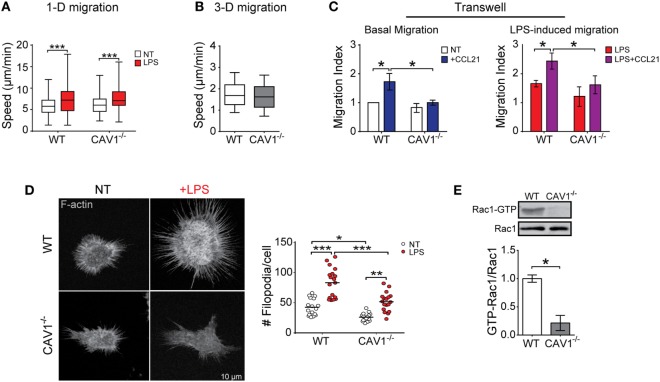
Caveolin-1 (CAV1) promotes dendritic cell (DC) transmigration, actin membrane protrusions, and Rac1 activation. Migration of wild-type (WT) or CAV1−/− bone marrow-derived DCs (BM-DCs) in different in vitro assays. (A) BM-DCs treated or not with LPS (1 µg/ml, for 30 min) were individually tracked in confined microchannels (4 µm). After 5–6 h, cell images at different positions along the channels were recorded during 10–12 h (one photo each 2 min) using an automated microscope. The reconstructed movie is analyzed, and the average speed of every cell obtained. In the box plots, the bars include 90% of the data points, the center corresponds to the median, and the box contains 75% of the data points. Data from two different experiments, n = WT: 221, WT + LPS: 153, CAV1−/−: 120, CAV1−/− + LPS: 236 cells (***p < 0.001). (B) Chemotactic migration of LPS-treated WT or CAV1−/− BM-DCs embedded in a 1% bovine collagen gel containing a CCL21 gradient. Mean velocity of LPS-DCs depicted as a function of the distance to the CCL21 source. In the box plots, the bars include 90% of the data points, the center corresponds to the median, and the box contains 75% of the data points. n = WT: 1,090, CAV1−/−: 1,169 tracks, from two independent experiments. (C) DC transwell migration. The bottom side of transwell membranes was coated with fibronectin to avoid losing migratory cell. In the bottom chamber, RPMI medium containing 0.5% fetal bovine serum with or without CCL21 (20 ng/ml) was added. Then, 2 × 105 of WT or CAV1−/− BM-DCs were seeded in the upper chamber, and migration was evaluated by counting cells on the bottom surface of the membrane. Left panel, immature BM-DC migration after 1 h. Right panel, LPS-matured BM-DC migration after 30 min. The migration index (relative to spontaneous WT DC migration) is shown. Bars are mean ± SEM (*p < 0.05, n = 3). (D) In the left panel, representative confocal microscopy images showing F-actin (phalloidin staining) in WT or CAV1−/− BM-DCs treated or not with LPS (100 ng/ml, 24 h). To the right, the quantification of protrusions per cell is shown. Each dot corresponds to one cell, and the black bar represents the mean (*p < 0.05, **p < 0.01, and ***p < 0.001, n = 18 cells, two experiments). (E) GTP-Rac1 levels were determined in WT and CAV1−/− DCs using pull-down assay followed by Western blot. Representative blots showing the active GTP-bound fraction and total Rac1. The ratio between active and total Rac1 is shown in the plot (densitometry analysis). Data are the mean ± SD (*p < 0.05, n = 3).